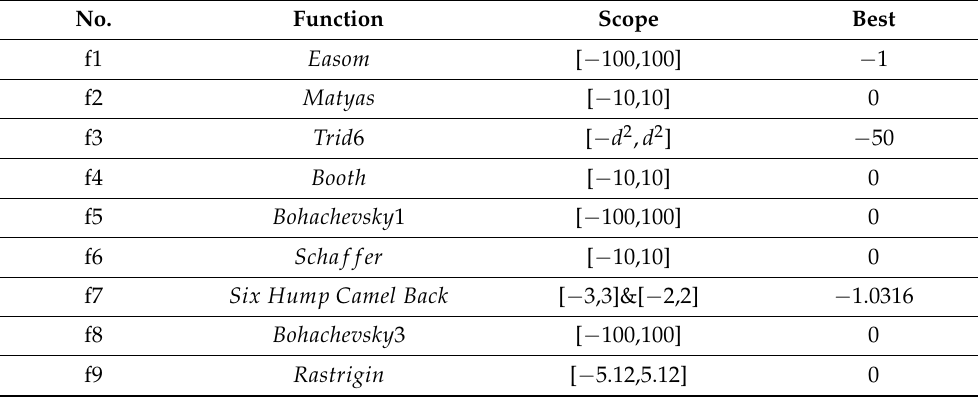
Table 1. Benchmark functions.